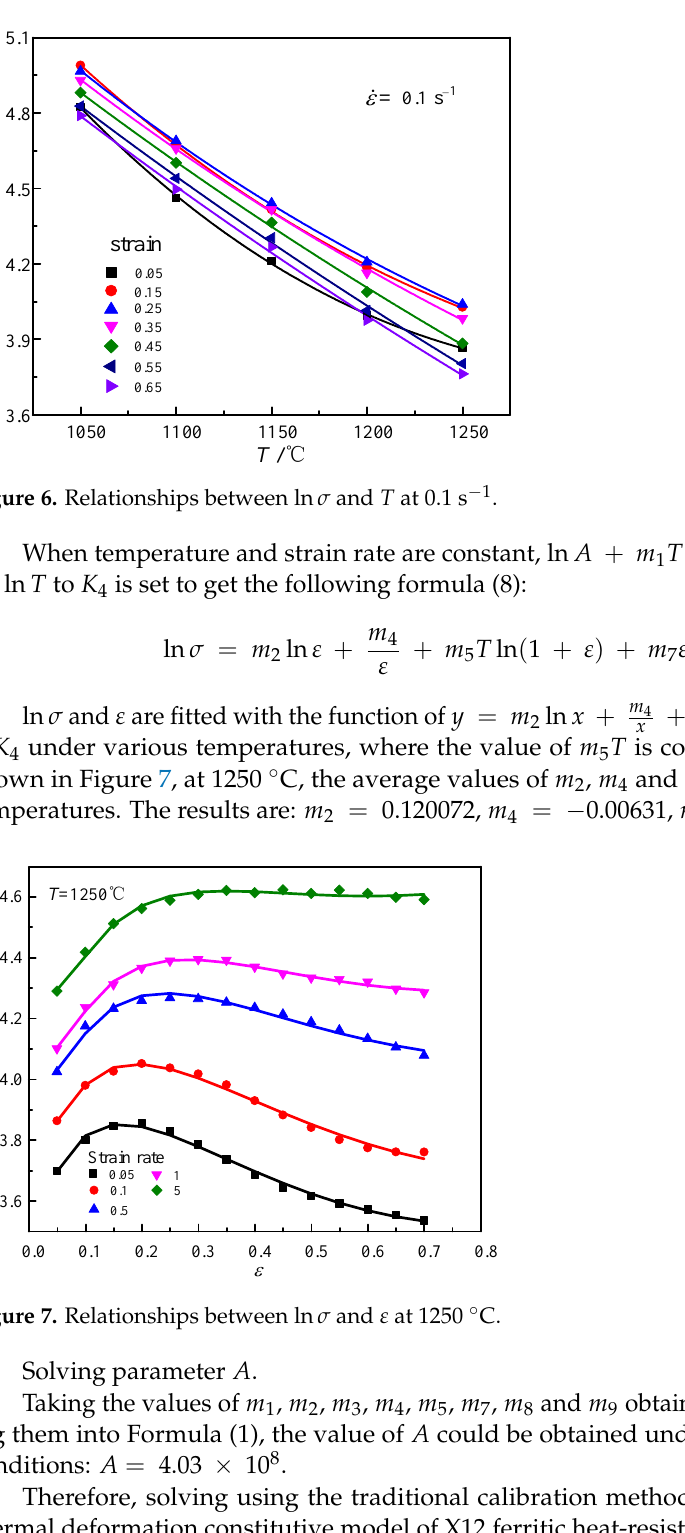
obtained as –1.59444. With a = m 1 + m 5 ln ( 1 + ε ) + m 8 ln constant; it can be fitted with formula y = m 5 ln ( 1 + x ) + K 3 (where K 3 = m 1 + m 8 ln under various strain conditions. The values are m 5 = 0.001173, m 1 = − 0.00311.